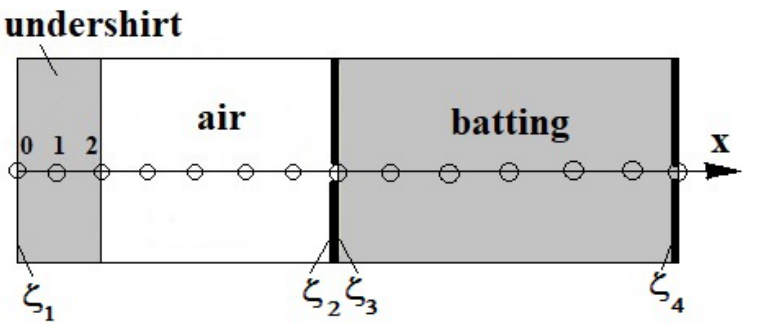
Figure 5. Sketch of the garment geometry. ζ i are emissivities. Circles are nodes of the computational